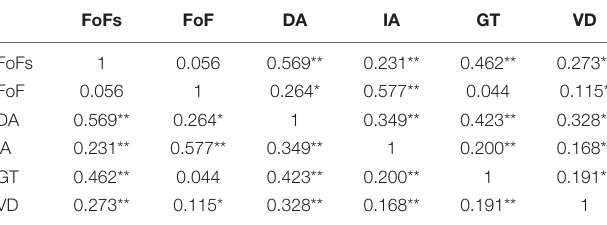
TABLE 2 | Intercorrelations between TCAGTQ